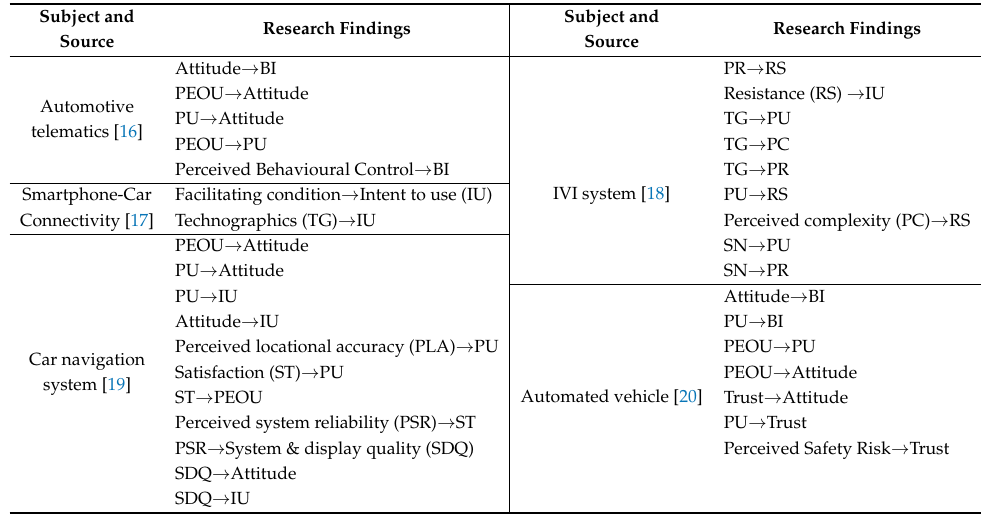
Table 1. Technology acceptance in Intelligent Transport System